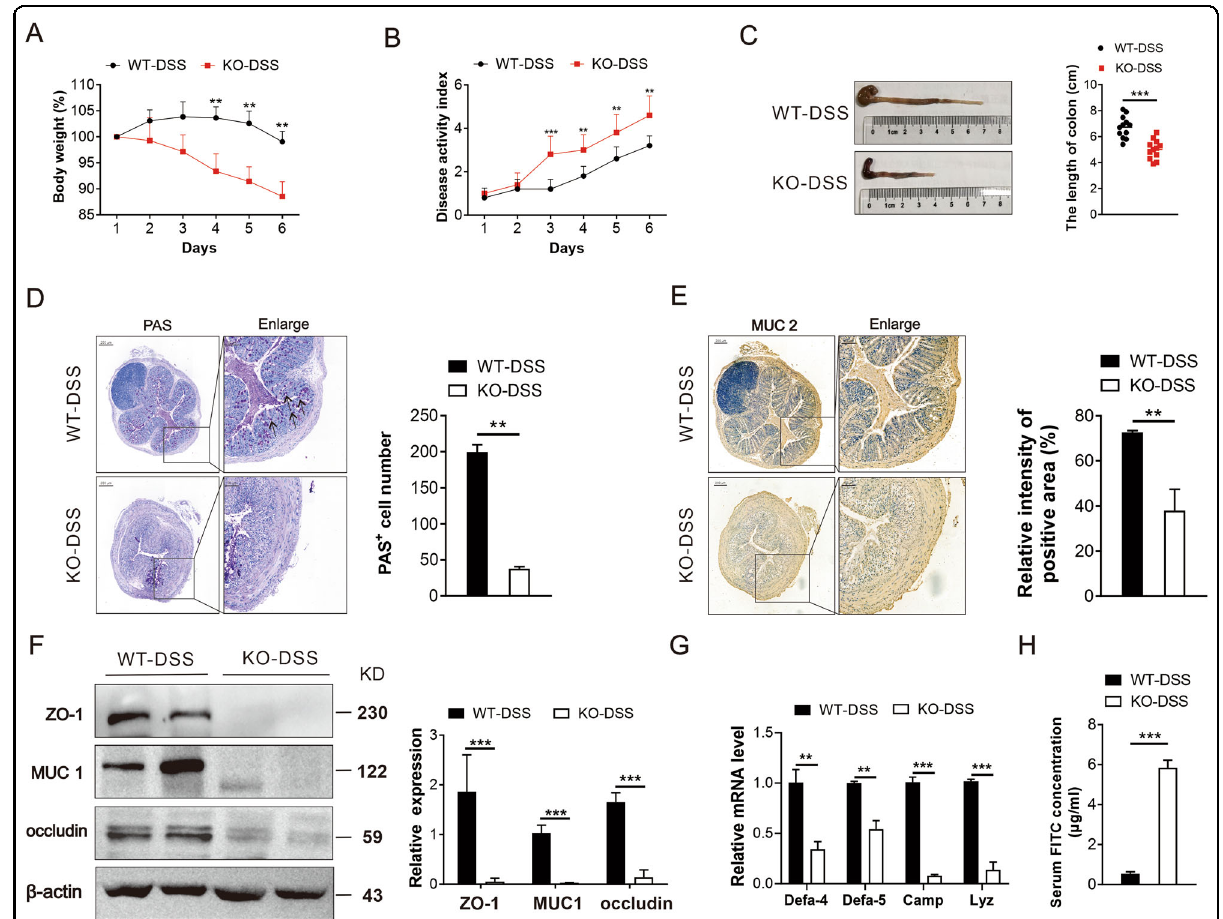
Fig. 1 KO mice are susceptible to DSS-induced intestinal in fl ammation. QKI fl / fl (WT) and LysM-Cre QKI fl / fl (KO) mice were administered 3% DSS for 6 days to induce acute colitis. Mice body weight change ( A ) and disease activity index (DAI) ( B ) were assessed daily as described in “ Methods ” ( n = 12/group). C Gross morphology of colons from WT-DSS and KO-DSS mice. The length of colon was measured on day 6 ( n = 12/group). D Representative images of periodic acid-Schiff (PAS)-stained colons and statistical analysis the PAS-positive cells number in colon. Black arrows pointed to the PAS-positive cells. Scale bars: 200 μ m (whole colon sections) and 50 μ m (enlarged insets). E Expression of MUC2 in the colon was evaluated using immunohistochemistry. Representative images of MUC2 expression in mice colon were shown. The staining intensity of positive area of MUC2 expression was calculated by the percentage of positive area. Scale bar: 200 µm (whole colon sections) and 50 μ m (enlarged insets). F Western blotting analysis of the protein expression of MUC1, ZO-1, and occludin in the colon of WT-DSS and KO-DSS groups. G mRNA level of antimicrobial peptides including Defa-4 , Defa-5 , Camp , and Lyz were detected by q-PCR. H Serum FITC concentration was detected after the mice were orally administered with FITC-labeled dextran ( n = 5/group). All bars represent the mean of measurements from three independent experiments, and the error bars indicate ±SEM; * P < 0.05, ** P < 0.01, *** P < 0.001, by unpaired, two-tailed Student ’ s t test ( A – H